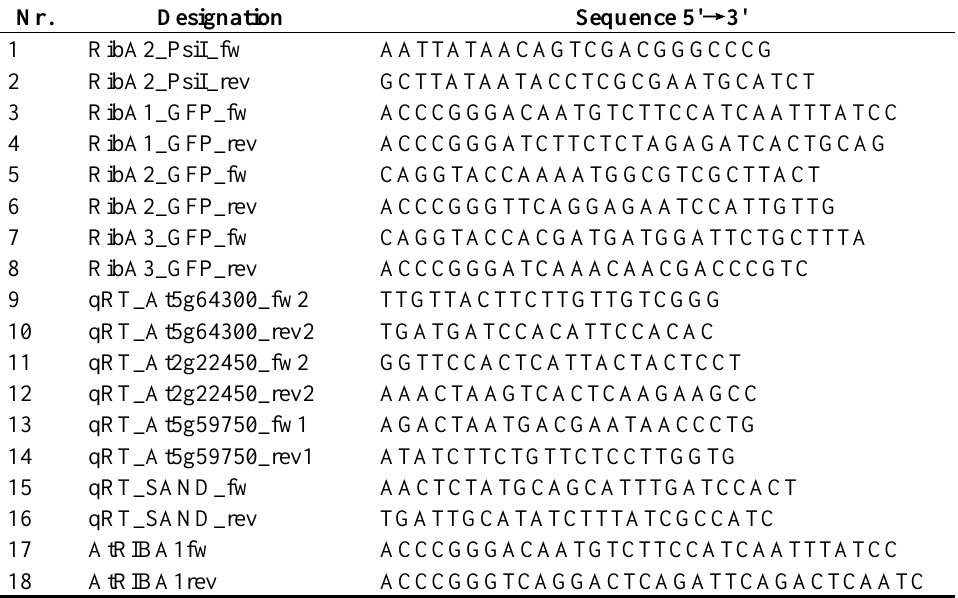
Table S1. List of used